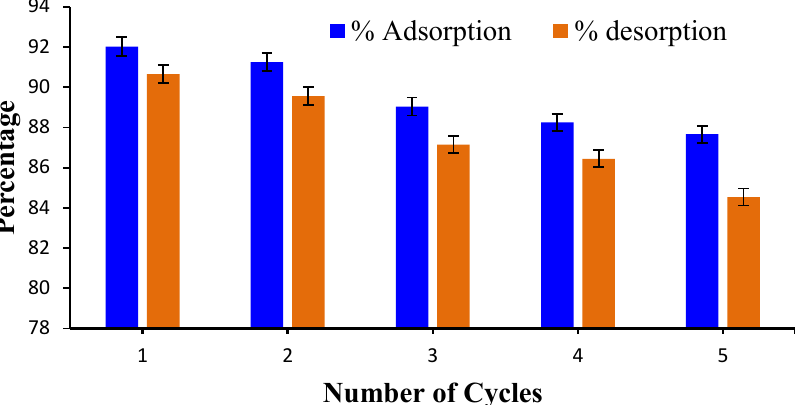
Figure 6. Desorption of Cd(II) ions and reusability of XG-cl-poly(AAm-co-AA) hydrogel for the ad- sorption .